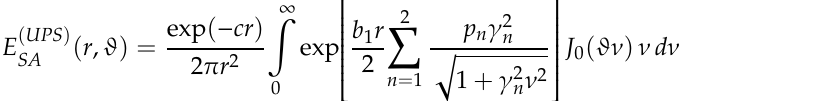
Figure 3. The delay of the “center of gravity” of the pulse (in nanoseconds) because of the scattering of light in water depending on the angle ϑ at various optical distances τ (indicated by the numbers in the figure); c = 0.4 m − 1 .